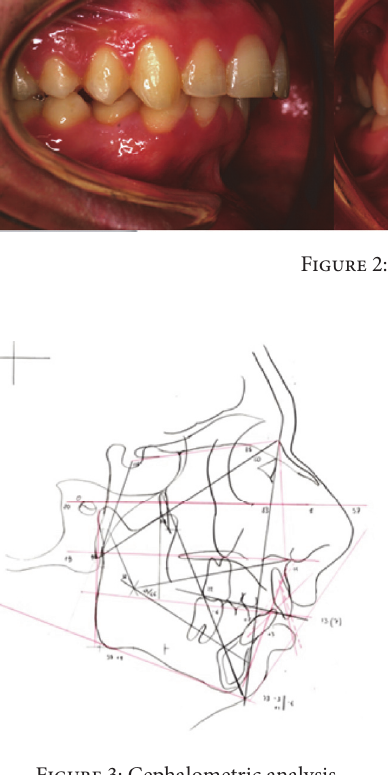
Figure 3: Cephalometric analysis.